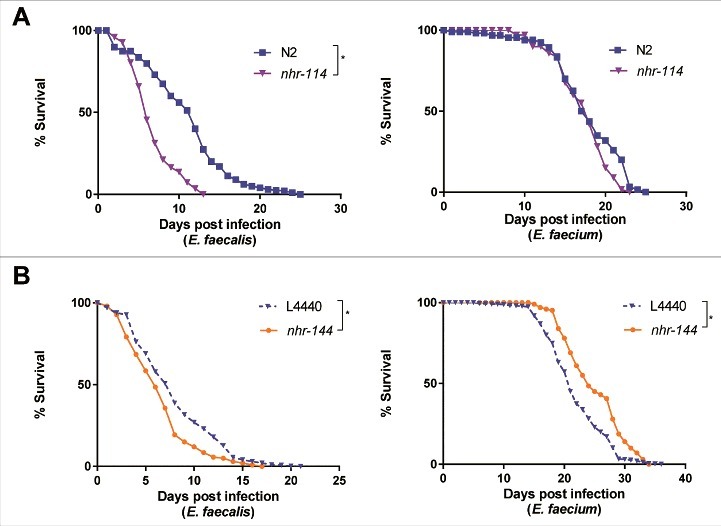
Nuclear hormone receptors are required for defense against Enterococcus. (a) Effect of E. faecalis and E. faecium infection on the survival of wild-type N2 and nhr-114(gk849). (b) Effect of E. faecalis and E. faecium infection on fer-15(b26);fem-1(hc17) C. elegans treated with L4440 vector control or nhr-144 RNAi. Results are representative of 2 independent assays. Each graph shows the average of three plates for each strain, with each plate containing 30–40 worms. Relevant statistically significant survival curves (relative to control) are marked with asterisks and a bracket. Statistical significance of differences between survival curves was calculated using Kaplan-Meier log rank analysis.